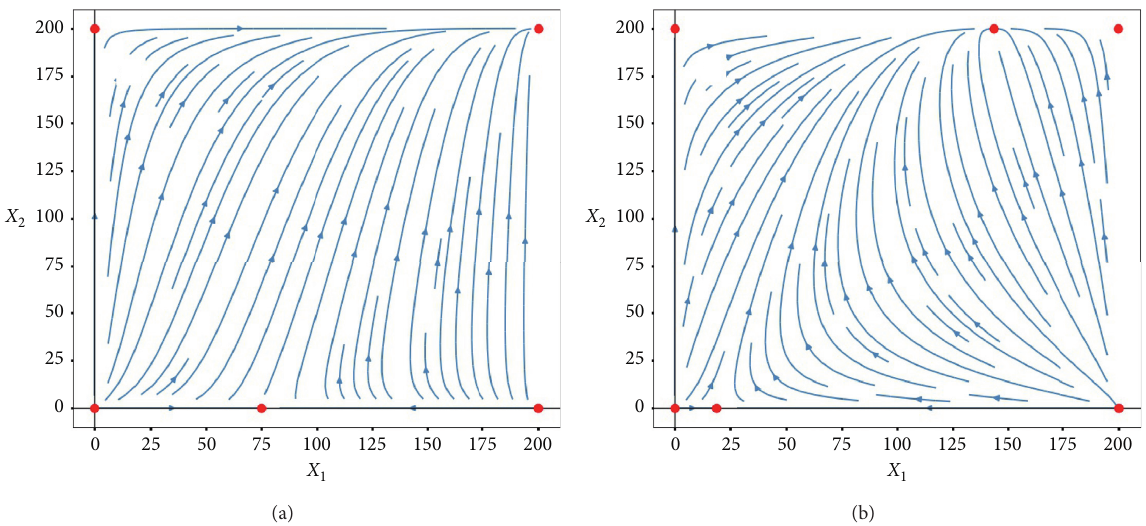
Figure 12: Facultative-facultative mutualism with intraspecific competition and cooperation: (a) we have the case where b b � 0 . 008; (b) we have b 22 solutions: four saddle points, four unstable points, and only one stable solution.